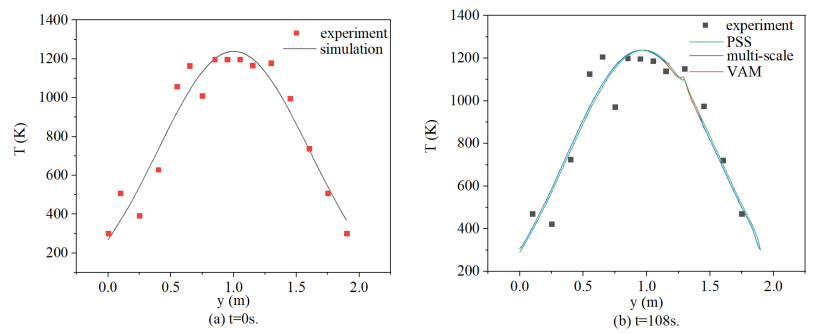
Figure 7. Experimental and simulated temperature profiles with X CH 700 m 3 /h.